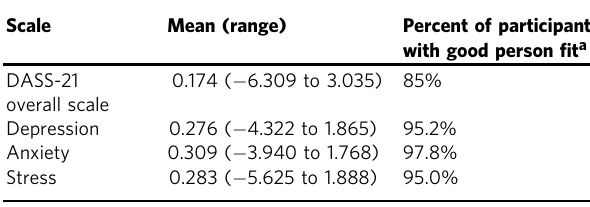
Table 5 Person fi t estimates of DASS-21 and its